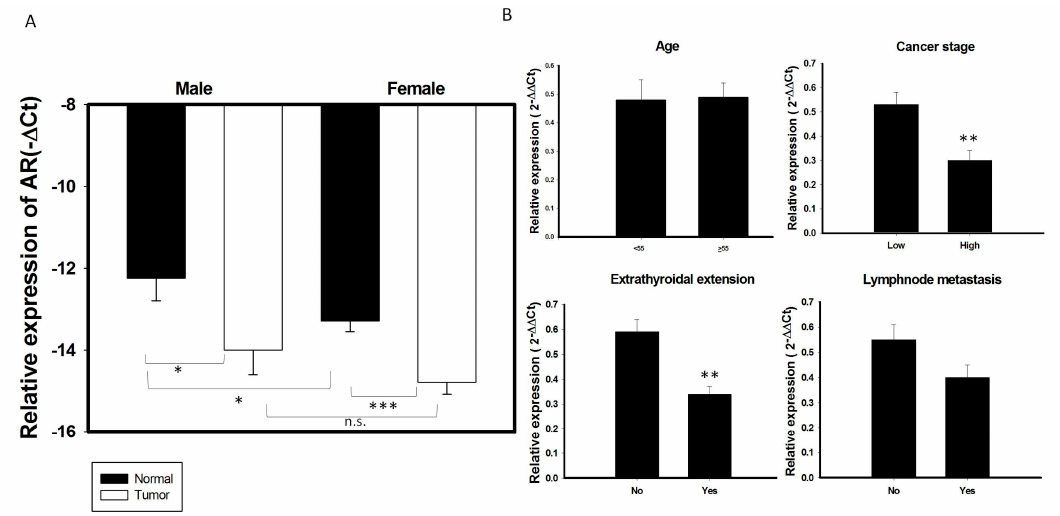
Figure 2. Association of AR mRNA expression with clinical characteristics in 137 PTC samples. ( A ) The expression of AR mRNA is significantly decreased in PTC tumor specimens than its adjacent normal tissue in both male and female gender patients. ( B ) Association of AR with clinical features in 137 PTC patients stratified as follows: age; cancer risk, low risk (stage I + II) v.s. High (stage III + IV); the presence of lymph node metastasis and extrathyroidal extension. * p < 0.05 ** p < 0.01 *** p < 0.01 n.s: non- significant.